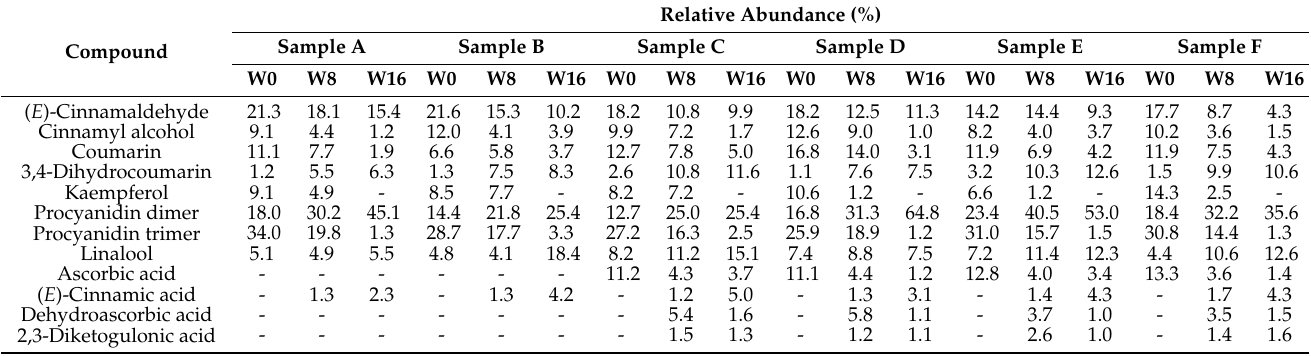
Table 7. Chemical constituent analysis of all stability test samples by LC-MS. Identification was based on their specific m / z values and comparison to literature data and MS database. The details of sample code refer to Table 1. W refers to